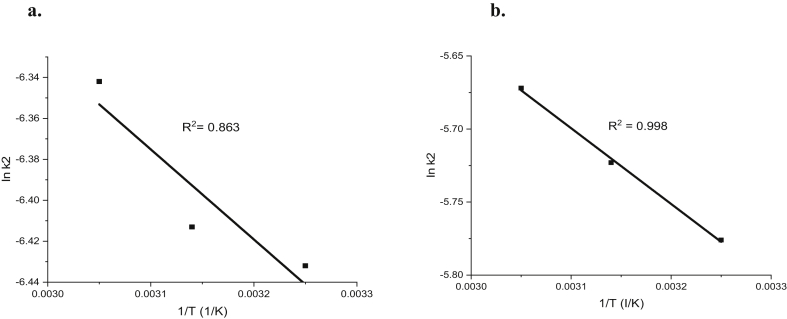
Arrhenius plots of Ink2 against 1/T for (a) Cd(II) and (b) Cr(VI) adsorption on the surface of Multiwall carbon nanotubes.